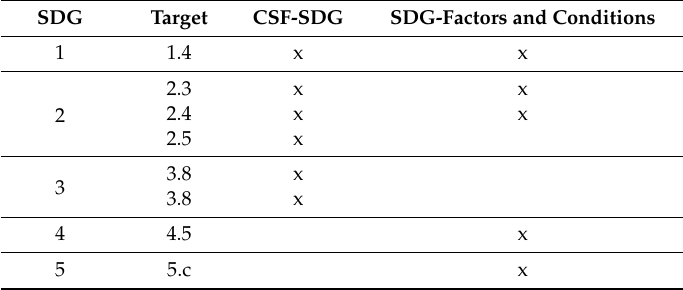
Table 3. Linking SDG, SDG targets, CSF, and CSF success factors and